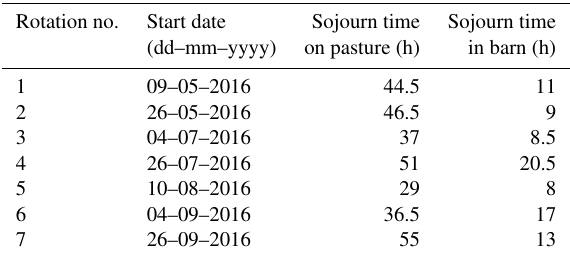
Table 1. Summary of grazing rotations in 2016 on paddocks X .11 and X .12 investigated for NH 3